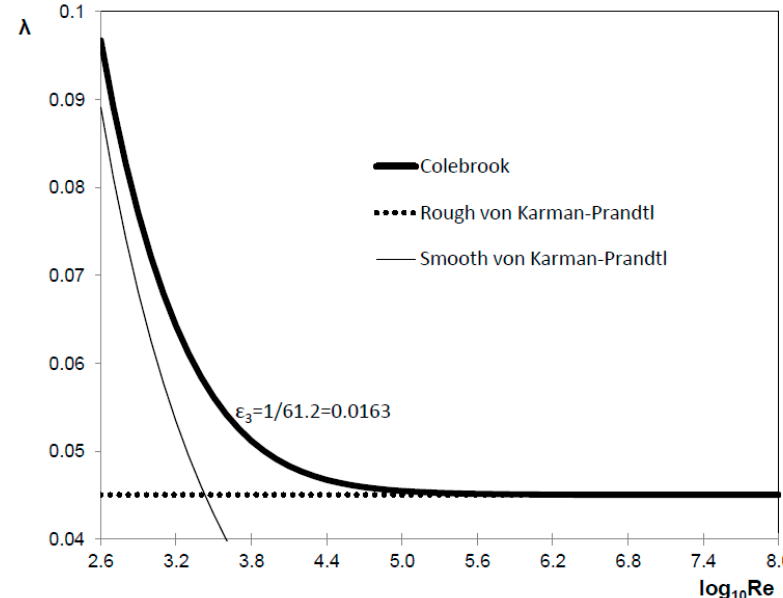
Figure 4. Von Karman–Prandtl equations for smooth turbulent flow and for fully rough turbulent flow unified by Colebrook using a logarithmic function in the one coherent hydraulic model.